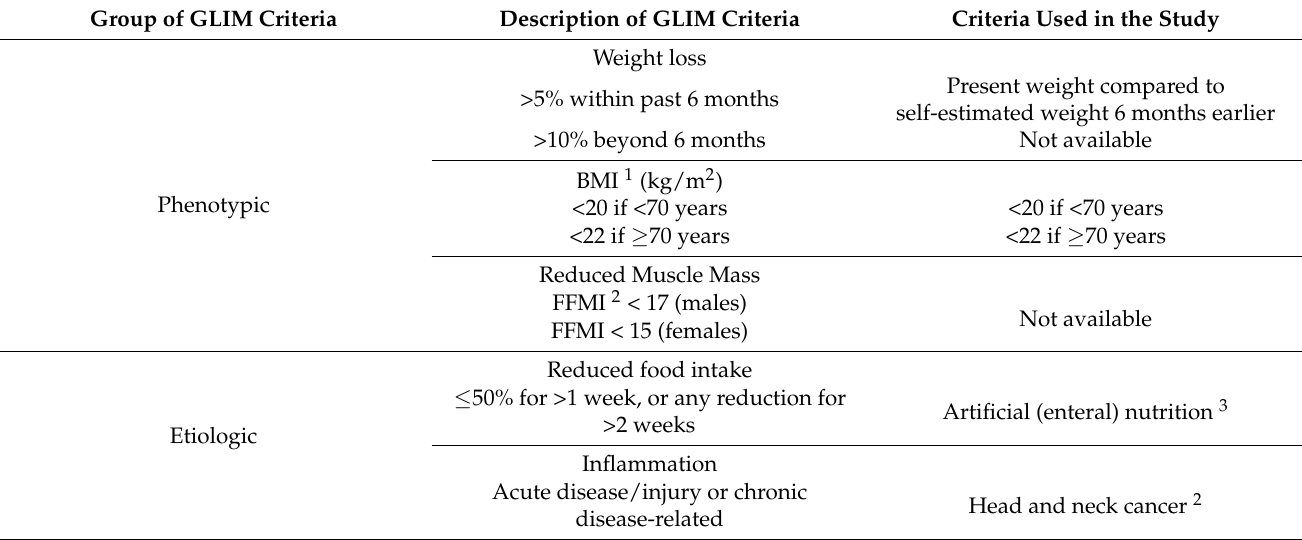
Table 1. Overview of how the GLIM Criteria for the Diagnosis of Malnutrition were used in the present